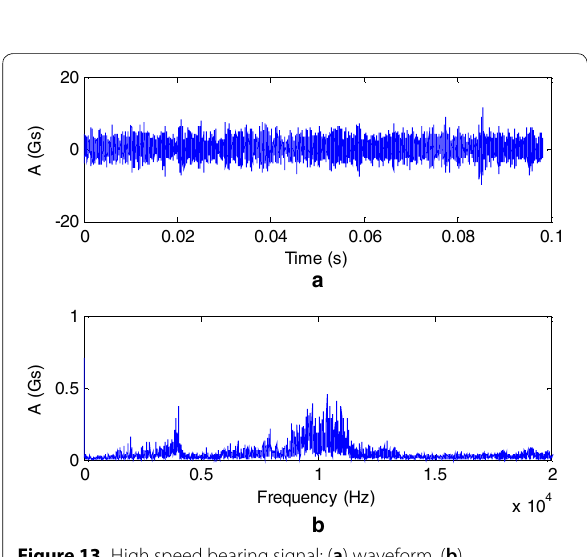
Figure 9 Bearing signal MEMD decomposition result: ( a ) waveform, ( b ) amplitude-frequency characteristic